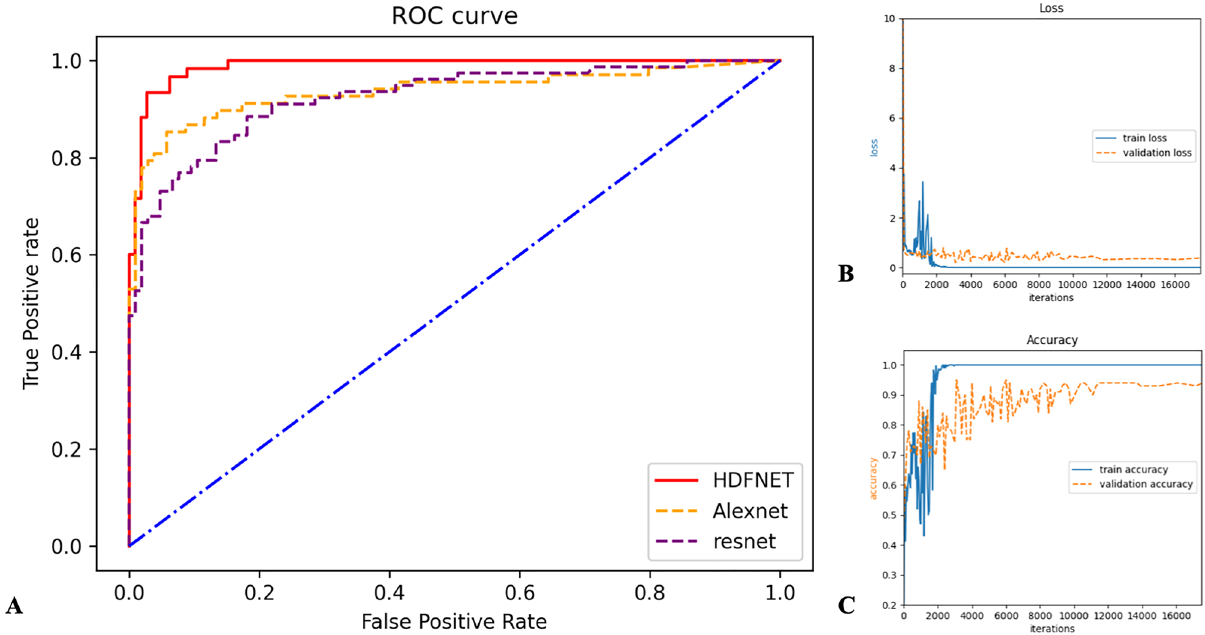
Figure 3. Receiver operating characteristic (ROC) curves and learning curve of the HDF-Net, ResNet50 and AlexNet for VA outcome prediction. ( A ) For binary classification tasks of VA improved or unimproved, the presented HDF-Net (red line) performs equally or better than the traditional AlexNet (orange line) and ResNet50 (purple line). ( B ) Loss versus iteration graph of HDF-Net showing loss of 0.351 at 16,000 iteration; ( C ) Accuracy versus iteration graph of HDF-Net showing a final validation accuracy of 93.6% at 16,000